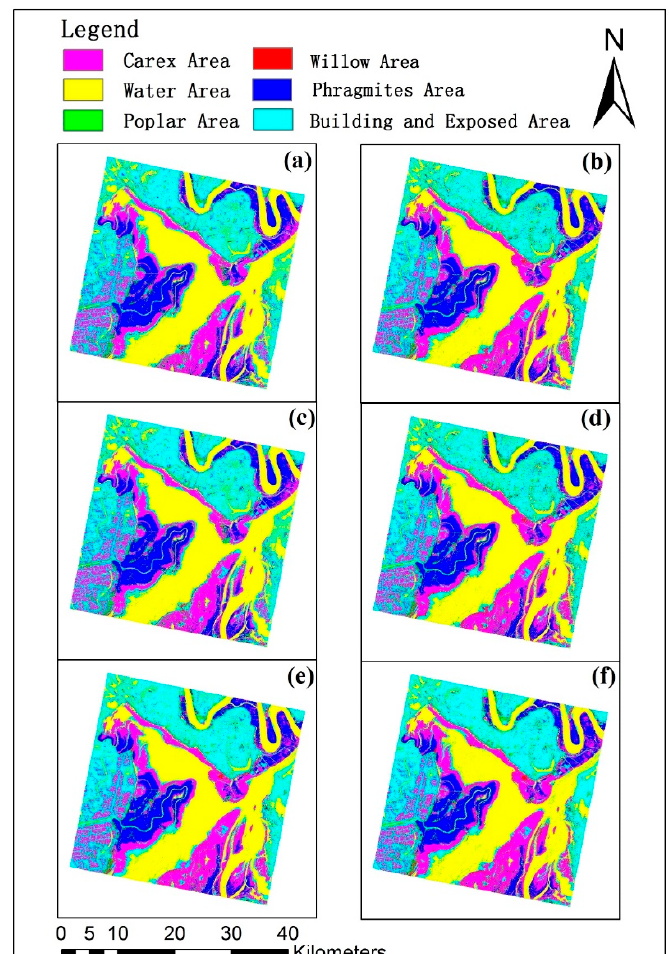
Figure 9. The comparison of land cover type classification maps using six methods to select the first four spectral variables: ( a ) JM distances; ( b ) correlation-weighted JM distances; ( c ) Divergences; ( d ) correlation-weighted divergences; ( e ) B-distances and ( f ) correlation-weighted B-distances.